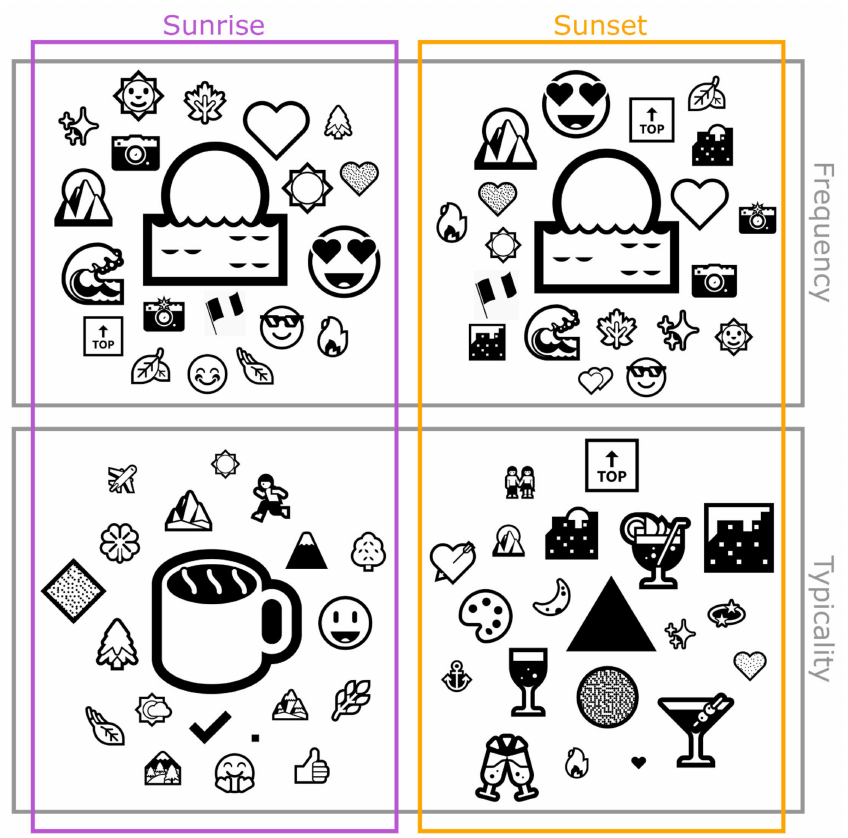
Figure 8. Emoji clouds of the frequency- and typicality-based top 20 emojis of the sunset- and sunrise-related sub-datasets of